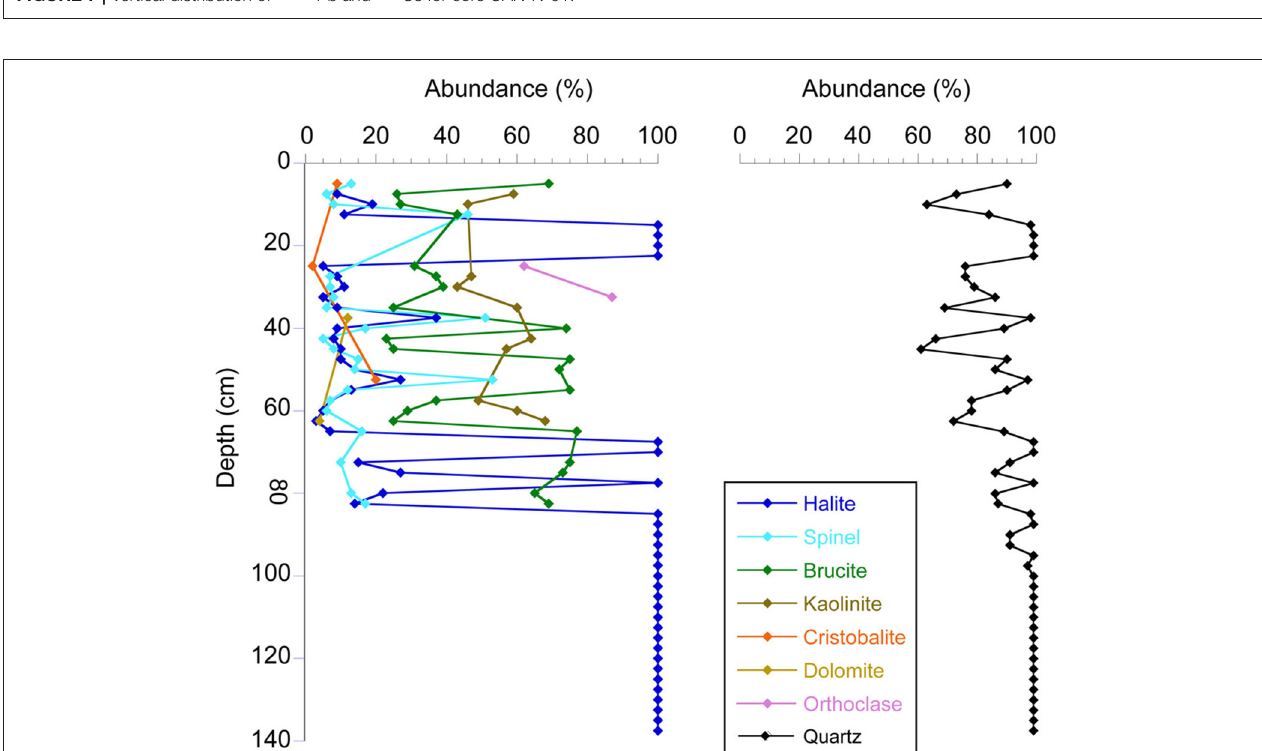
FIGURE 8 | Mineralogical distribution for core CAN-N-01: concentration of quartz on the right side and minor mineral fraction on the left side. Minor mineral abundances are expressed as normalized respect to quartz.